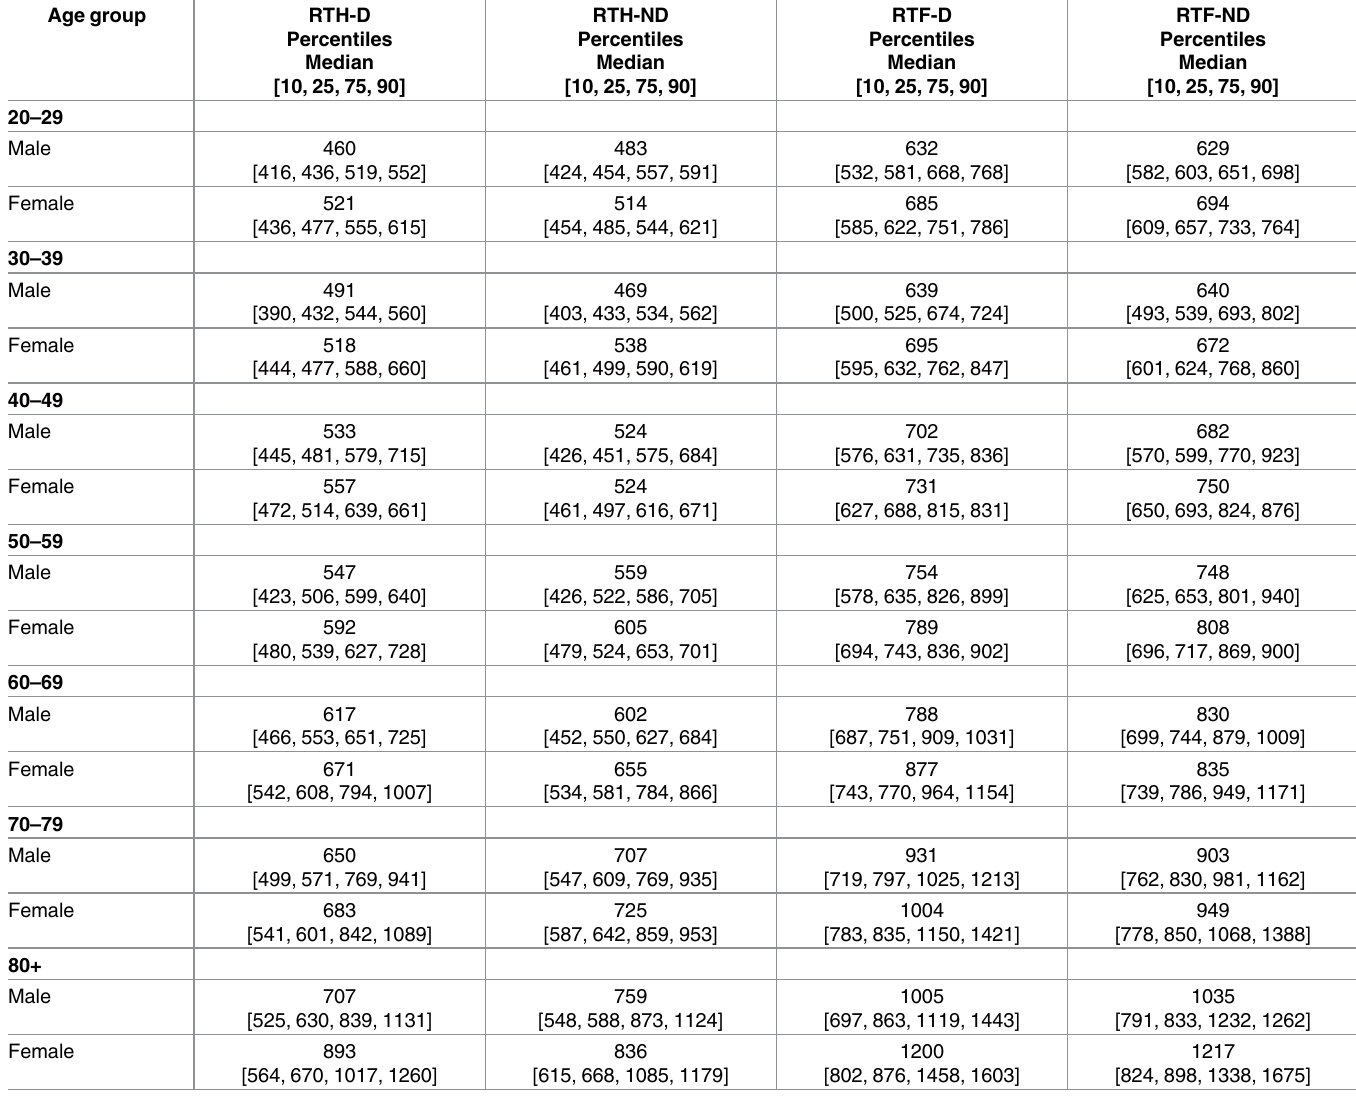
Table 2. Reaction time results (in percentiles) for male and female divided into age